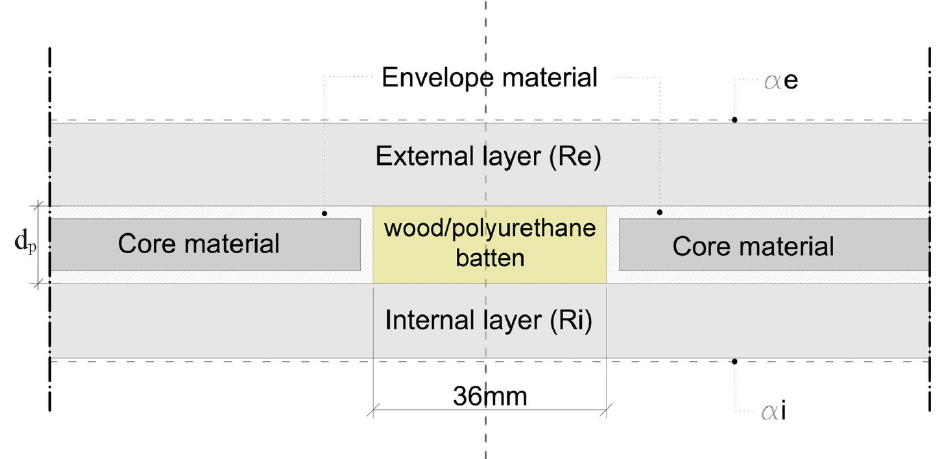
Figure 3. Model for the numerical calculation of the effective thermal conductivity of VIPs.